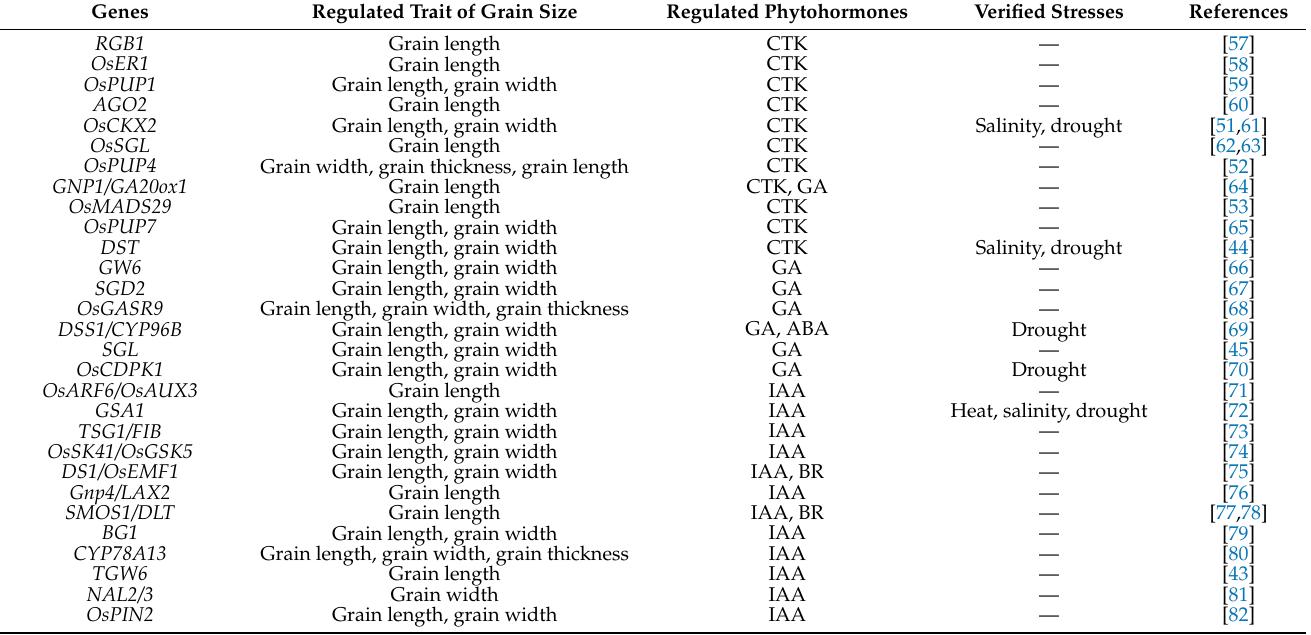
Table 1. The genes controlling grain